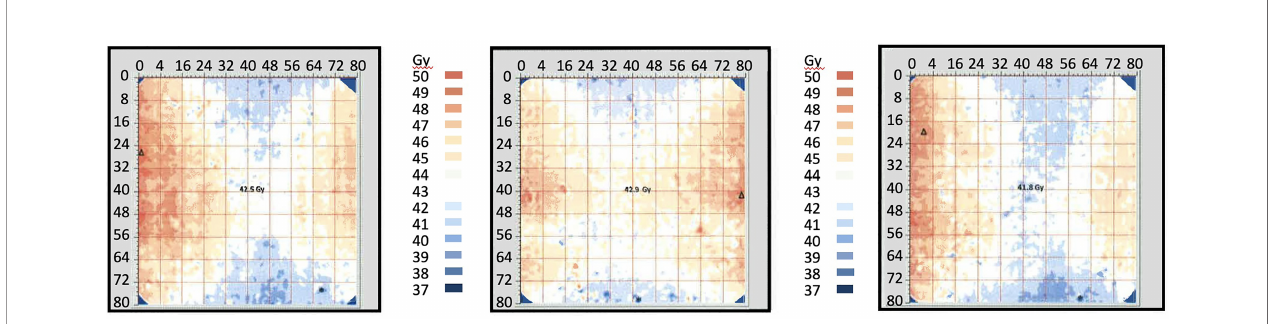
FIGURE 4 | Radiochromic fi lm mapping of the IC of the IMTCs: three runs. The image from run 1 is at left, from run 2 in the center and from run 3 is at right. The dose received at the center of the fi lm (position E) was 42.9 Gy (run 1), 41.8 Gy (run 2) and 42.5 Gy (run 3). See Table 2 for dose levels recorded for the minimum dose locations (position F, bottom center of each fi lm) and maximum dose locations (position H, at the side wall equator of each fi lm).